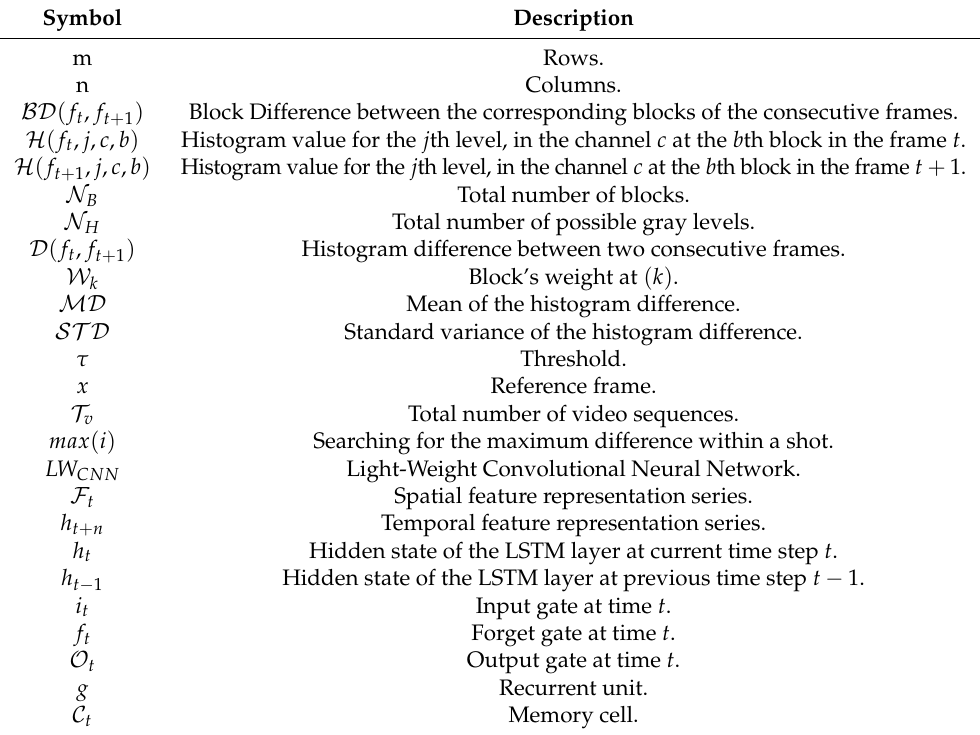
Table 1. Summary of the input and output parameters in the proposed